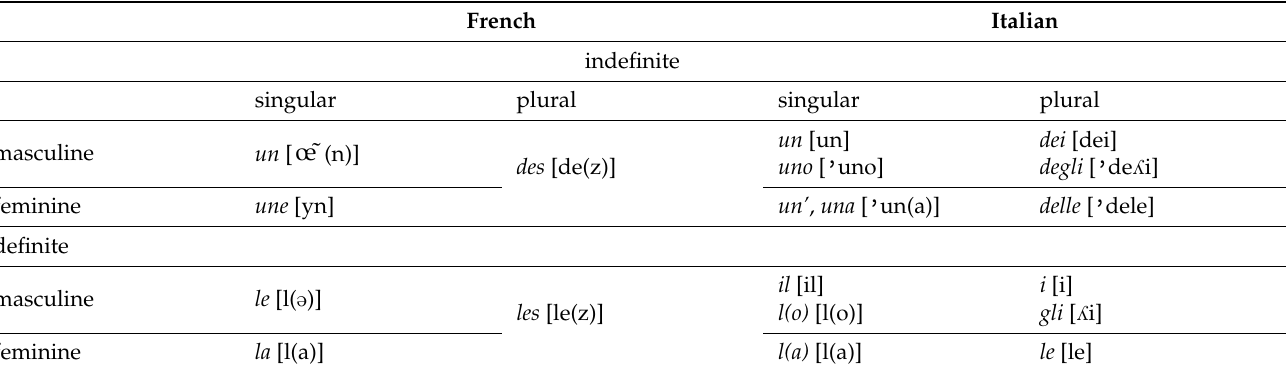
Table 1. Article systems of French and Italian.